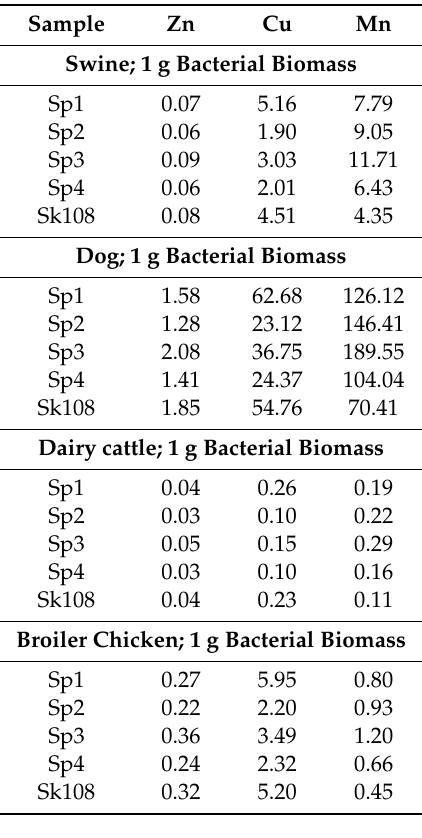
Table 6. Estimated daily supplementation [%] of microelements for selected animals with the use of methanotrophic bacterial biomass originating from di ff erent consortia. Each value is calculated for 1 g of bacterial biomass (according to references